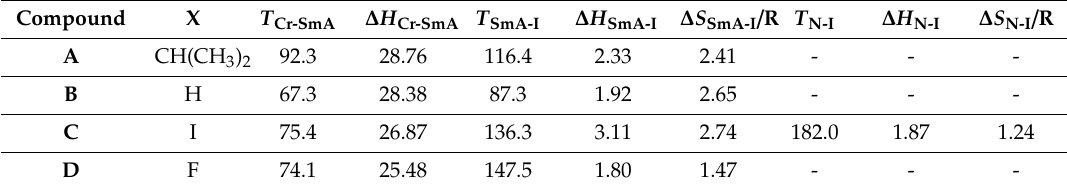
Table 1. Phase transition temperatures (°C), enthalpy of transitions (kJ/mol), and normalized transition entropy temperature for compounds A – D .